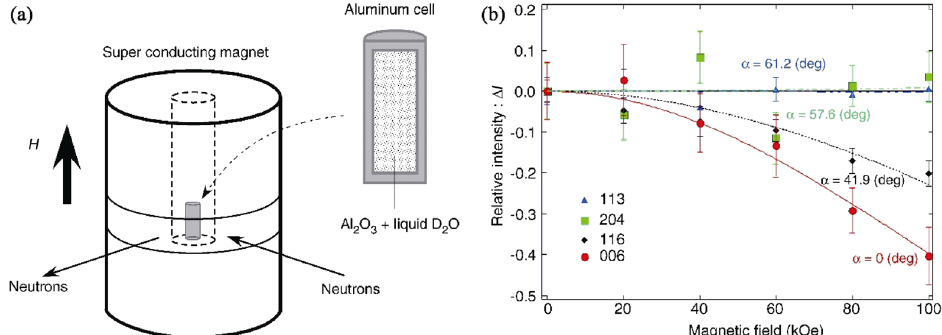
Fig. 20 Characterization of texture development of α-Al 2 O 3 suspension in a changing magnetic field: (a) schematic diagram of the experimental apparatus; (b) magnetic field dependence of diffraction intensities of different crystal planes of α-Al 2 O 3 . Reproduced with permission from Ref. [67], © American Institute of Physics 2008.